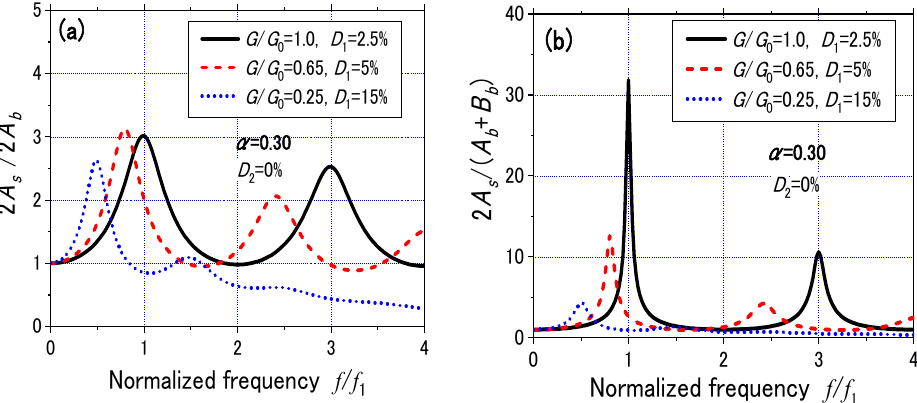
Figure 15. Calculated transfer function of two-layers model at three strain levels: Horizontal array (2 A s /2 A b ) ( a ), and Vertical array (2 A s /( A b + B b )) ( b ).